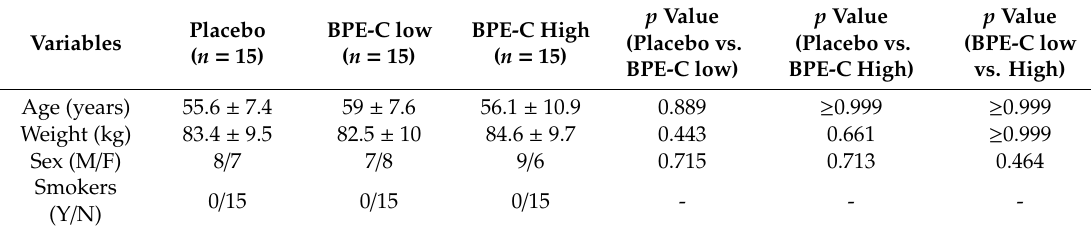
Table 1. The baseline characteristics of